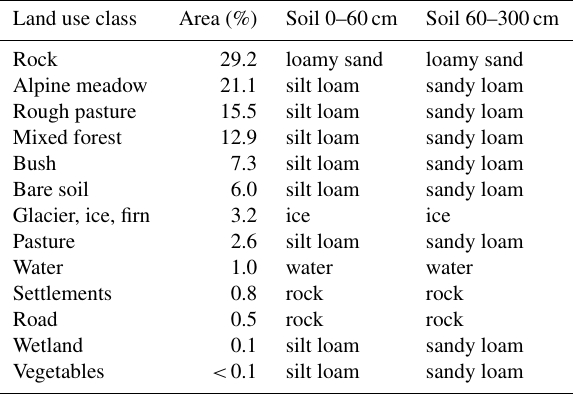
Table 3. Land use classes and corresponding soil